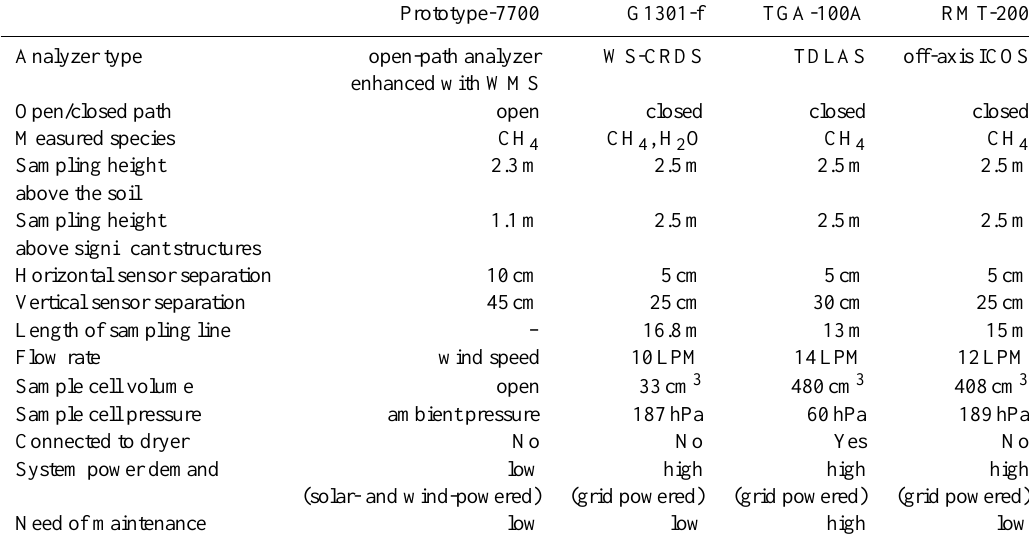
Table 1. Characteristics of the four methane gas analyzers and their respective